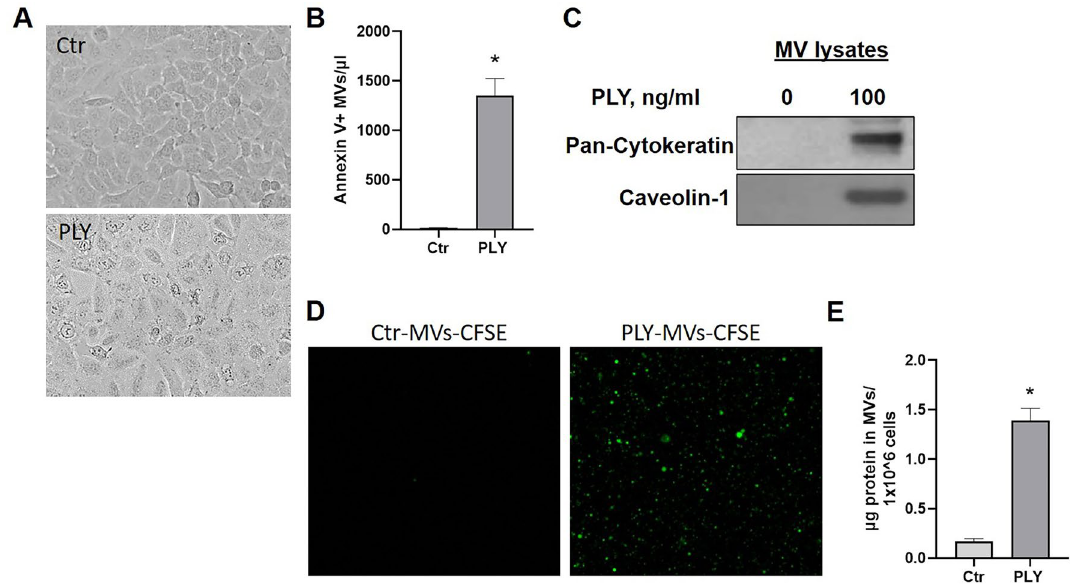
Figure 2. Pneumolysin (PLY) induces the release of alveolar epithelial microvesicles (MVs). A549 cells were treated with PLY (100 ng/ml) or PBS (Ctr) for 4 h. ( A ) Bright field images of cells 4 h after treatment. ( B ) Annexin V-positive ( +) MVs were quantified using FACS. N = 9, p < 0.0001 (upaired t-test). ( C ) MV lysates were probed with pan-cytokeratin and caveolin-1 antibodies. Depicted are representative blots (cropped images). ( D ) CFSE-MVs from Ctr or PLY-treated cells were visualized using confocal microscopy. ( E ) Protein amount in MVs derived from Ctr or PLY-treated cells. N = 9, *p < 0.0001 (unpaired